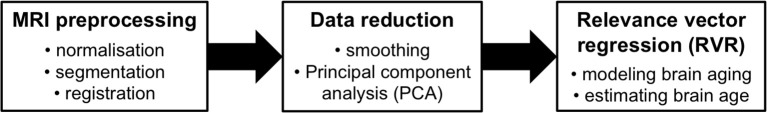
General flowchart of the brain age estimation framework.